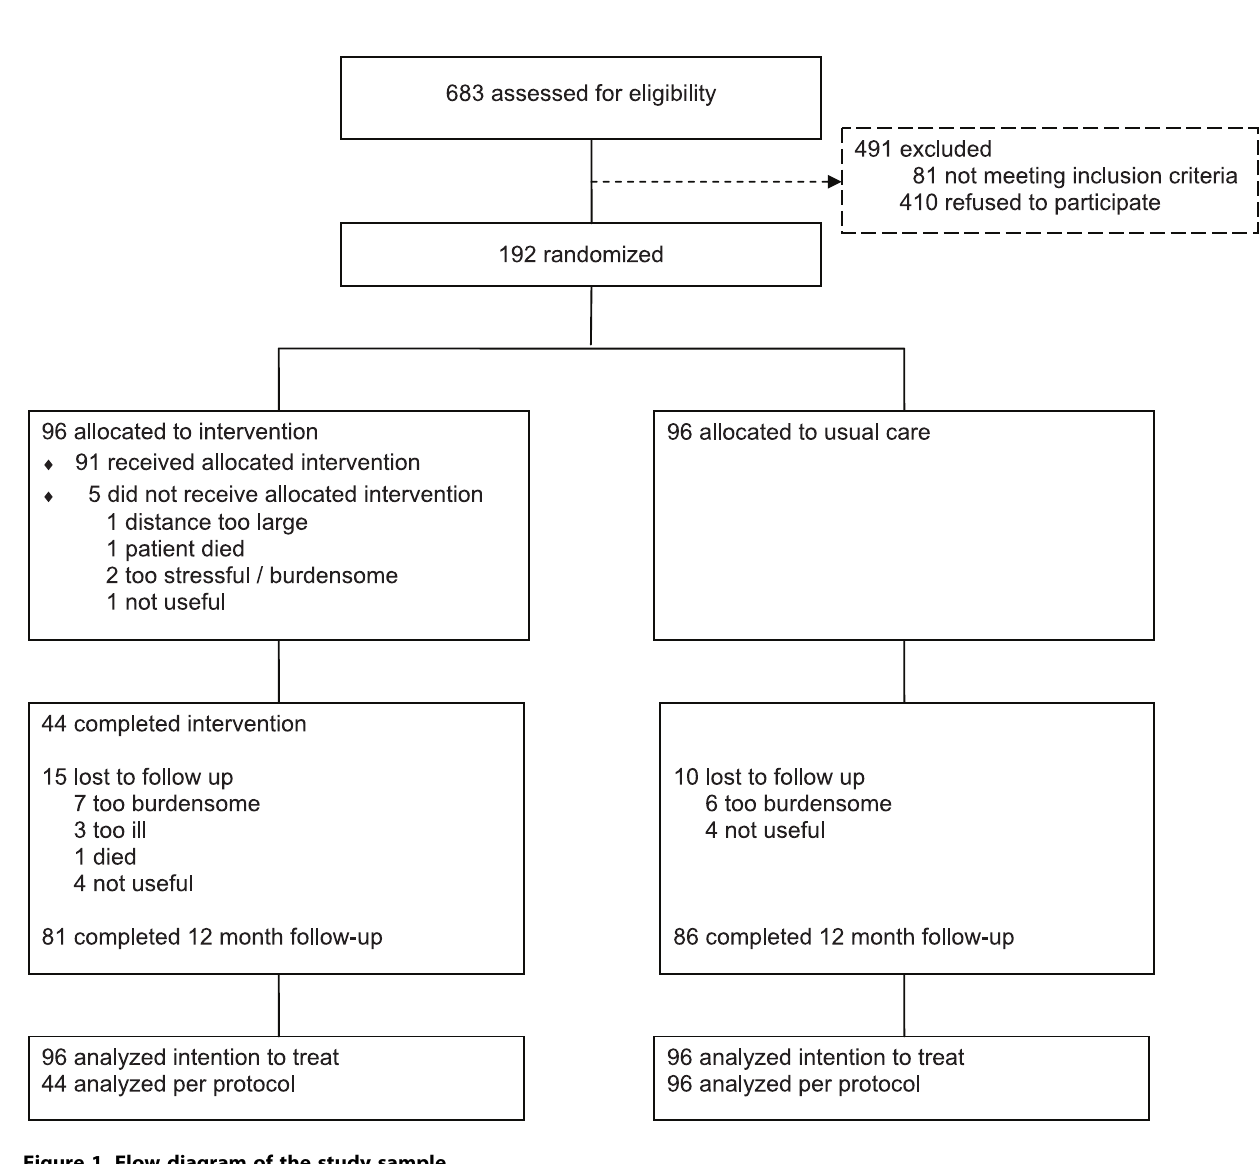
Figure 1. Flow diagram of the study sample.